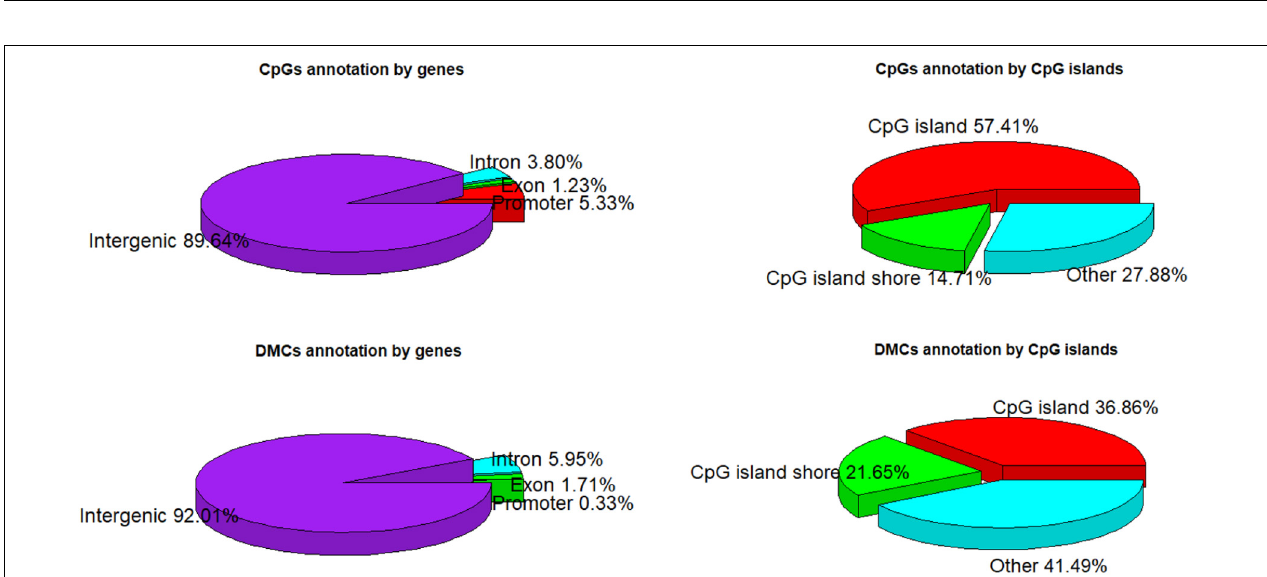
FIGURE 4 | CpGs and DMCs annotation by genes and CpG islands.